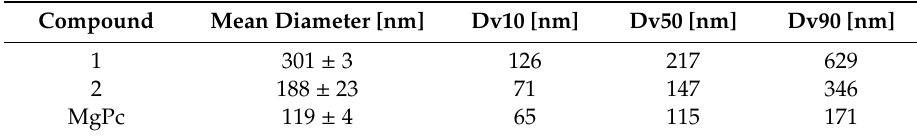
Table 2. Liposome particle size